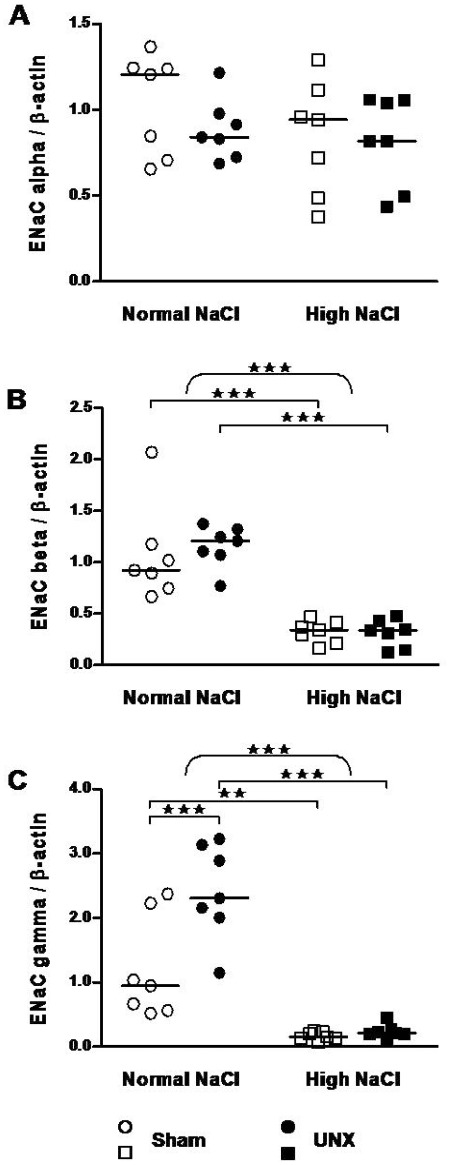
Impact of salt intake and uni-nephrectomy on epithelial sodium channel (subunits α, β, γ) mRNA expression in the rat colon. mRNA expression in epithelial cells isolated from colon (real-time PCR).Values were normalized with endogenous β-actin mRNA expression. Results were quantified relative to the mean of the sham-operated, normal salt group. Epithelial sodium channel subunits: A, alpha, B, beta and C, gamma. The horizontal line represents the median (n = 7). ★★, P≤0.01; ★★★, P≤0.001 indicate the effect of salt by two-way ANOVA (curly brackets; NS: normal salt; HS: high salt) or significant differences between groups (squared brackets, Bonferroni's post test).